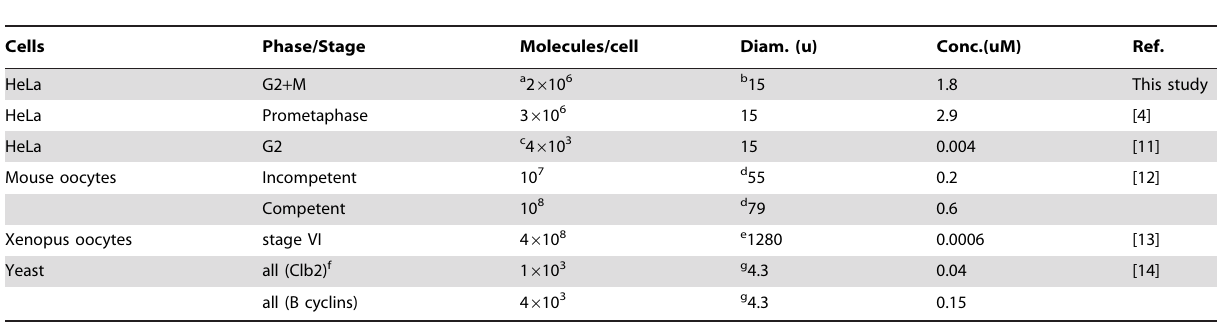
Table 2. Comparison of Cyclin B1